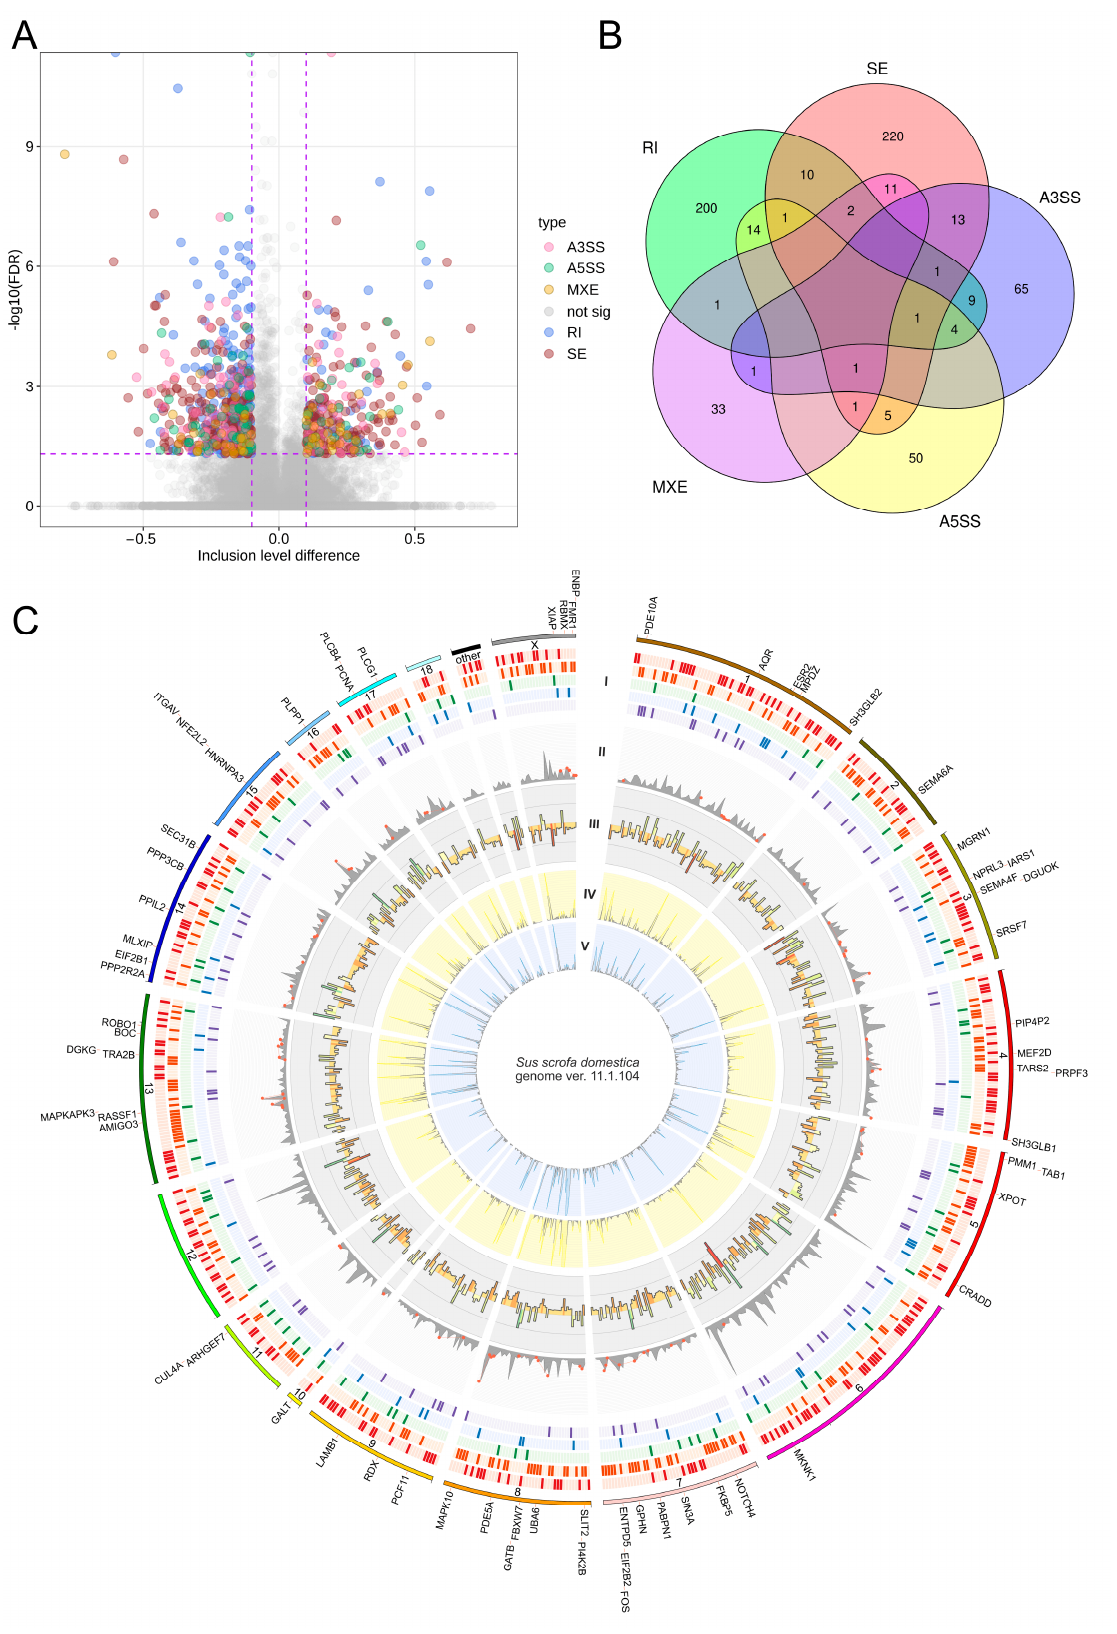
Figure 3. ( A ) Volcano plot showing inclusion levels di ff erences against the statistical signi fi cance of DASs identi fi ed within genes of porcine adenohypophyseal cells during EP compared to ML. The purple dashed lines indicate the applied cut-o ff thresholds, described in the text. ( B ) The Venn dia- gram characterizing the occurrence of distinct types of identi fi ed DASs within genes. ( C ) Circular chart visualizing the distribution within the domestic pig genome of identi fi ed DASs within porcine adenohypophyseal cells between EP and ML. The subsequent circles characterize the parameters of